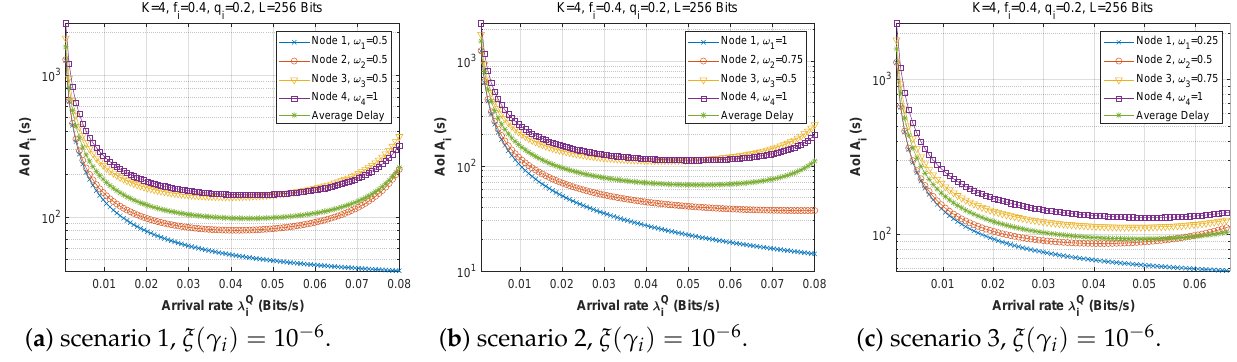
Figure 32. The AoI experienced at each mobile device when varying the arrival rate λ Q